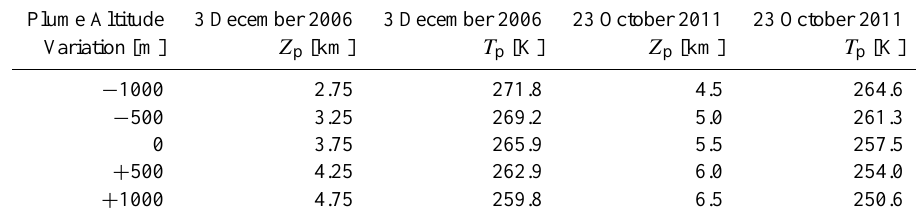
Table 4. Plume altitude variation, plume altitude, and plume temperature for the two test cases.